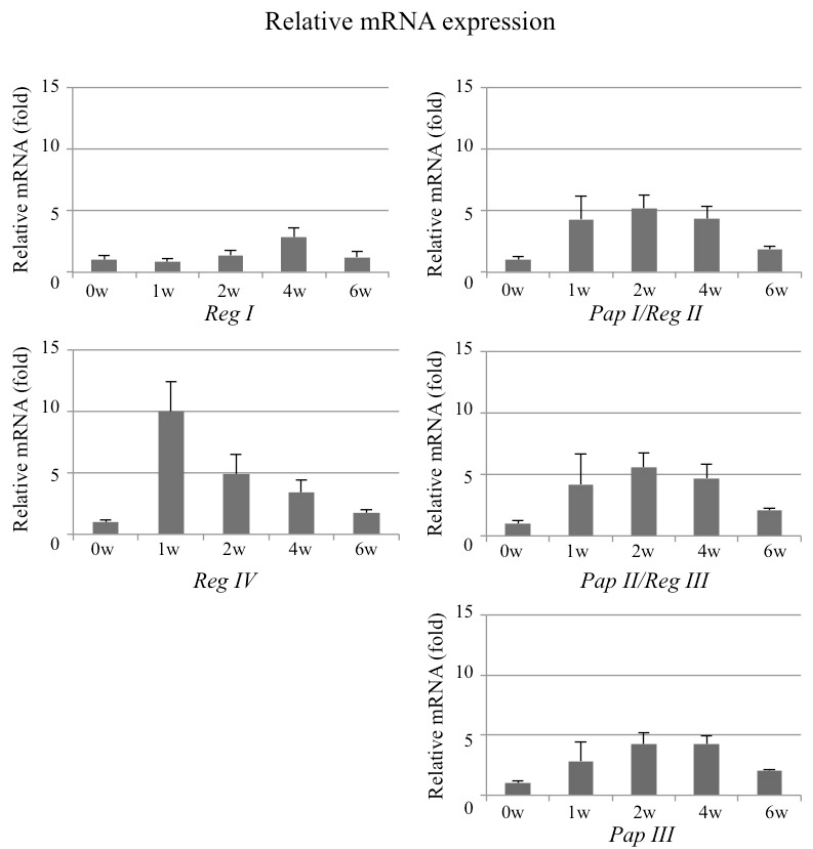
Figure 2. The expression of Reg family genes in the periosteum. The mRNA levels of rat Reg family genes ( Reg I , Reg IV , Pap I / Reg II , Pap II / Reg III , and Pap III ) in the periosteum before (0) and 1, 2, 4, and 6 weeks after the fracture ( N = 4 to 8). The data are indicated by mean ± SD. The mRNA levels before fracture (0 w) are set at 1. The level of Reg I mRNA at 4 weeks fracture was significantly increased ( p = 0.042 vs. 0 week). The levels of Pap I / Reg II mRNA at 1, 2, 4, and 6 weeks after fracture were significantly increased ( p = 0.0418, 0.0025, 0.0047, and 0.0254, respectively). The levels of Pap II / Reg III mRNA at 2, 4, and 6 weeks after fracture were significantly increased ( p = 0.0080, 0.0063, and 0.0150, respectively). The Pap III mRNA levels at 2, 4, and 6 weeks after fracture were increased ( p = 0.0113, 0.0005, and 0.0045, respectively). The Reg IV mRNA levels at 1, 2, and 4 weeks after fracture were increased ( p = 0.0006, 0.0403, and 0.0267, respectively). w = week.